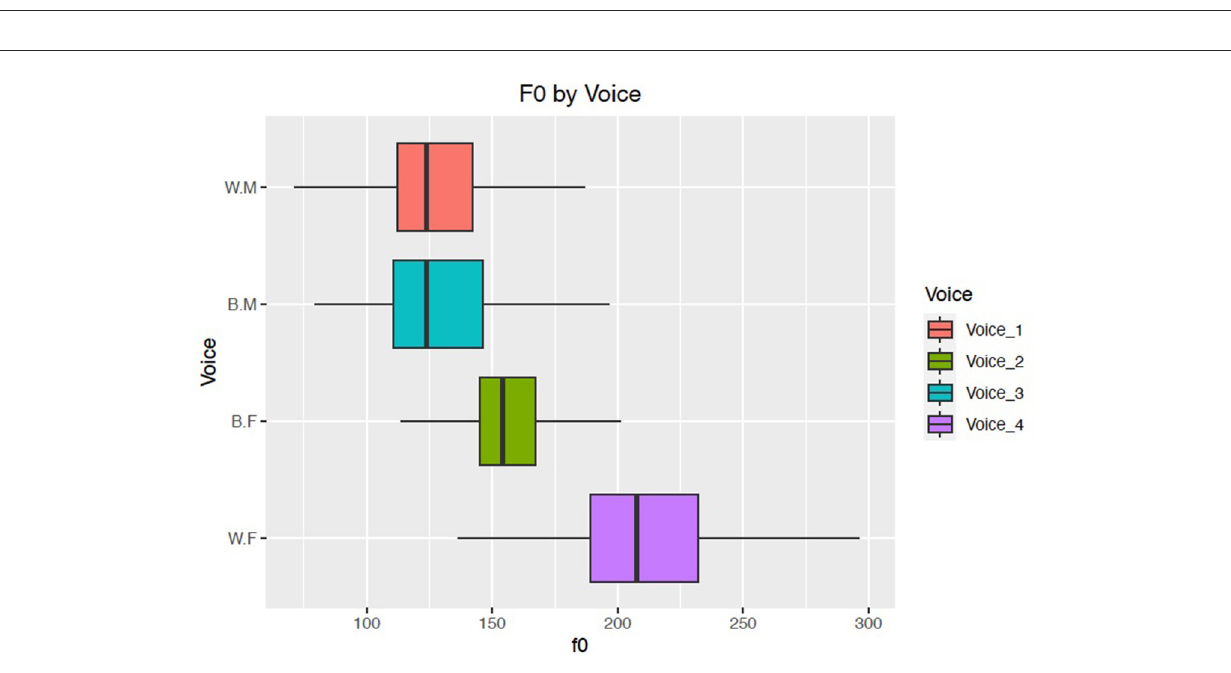
FIGURE7 Mean F0 values by voice/race